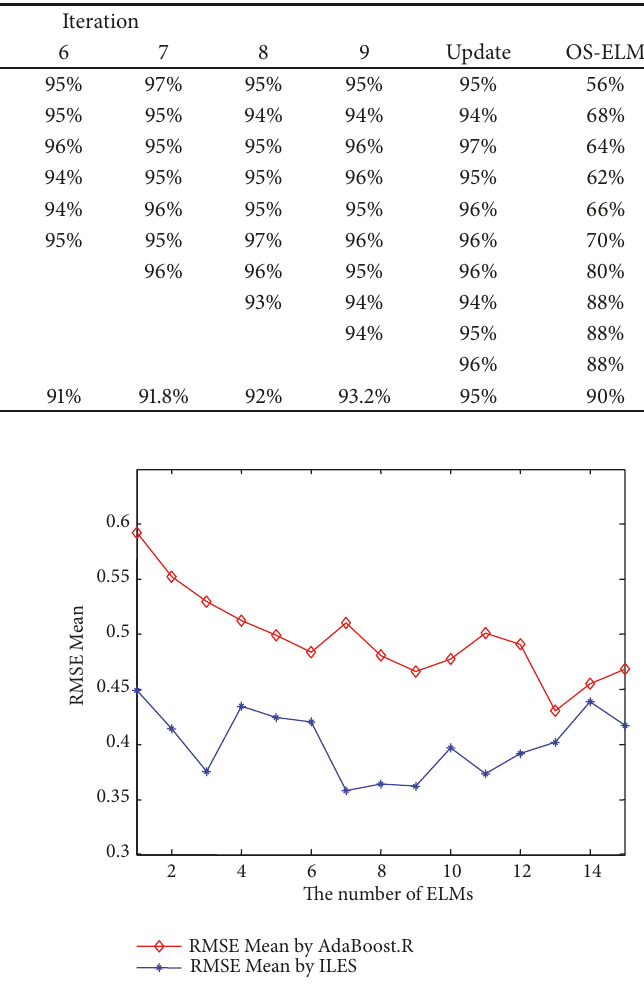
Figure 3: The performance trends of the ILES and AdaBoost.R with different parameters 𝑇 푘